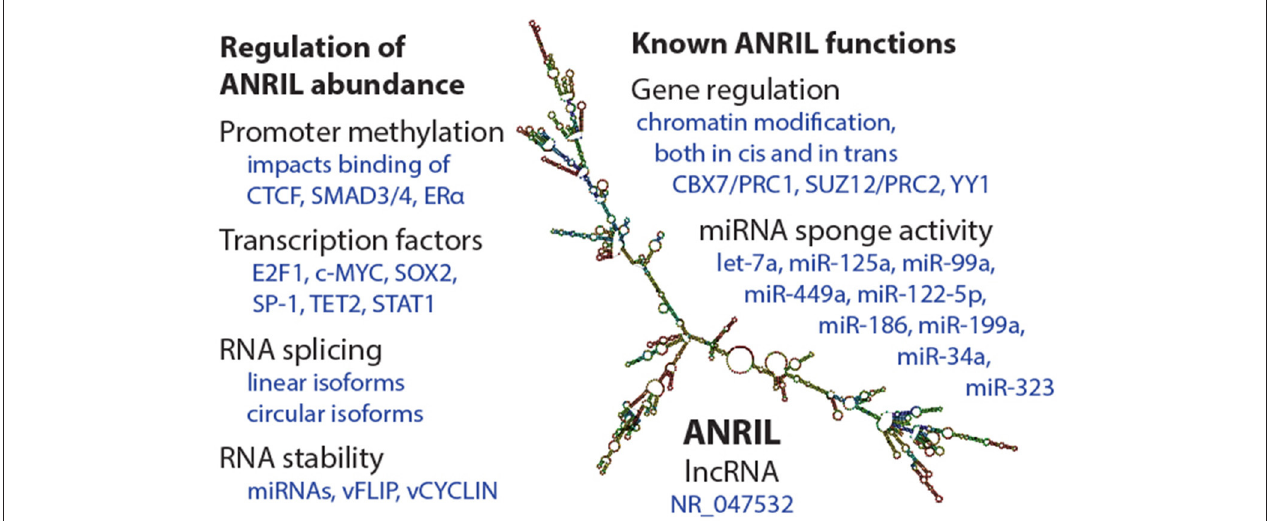
FIGURE 2 | Summary of regulation and functions of the ANRIL lncRNA. (Left) Some of the known mechanisms by which ANRIL abundance is regulated, at the transcriptional and post-transcriptional levels. On the (Right), a selection of known ANRIL cellular functions are depicted. We apologize for observations not included in this summary image. The ANRIL structural prediction in the center is of a common long-isoform of ANRIL, and was generated from Gruber et al.